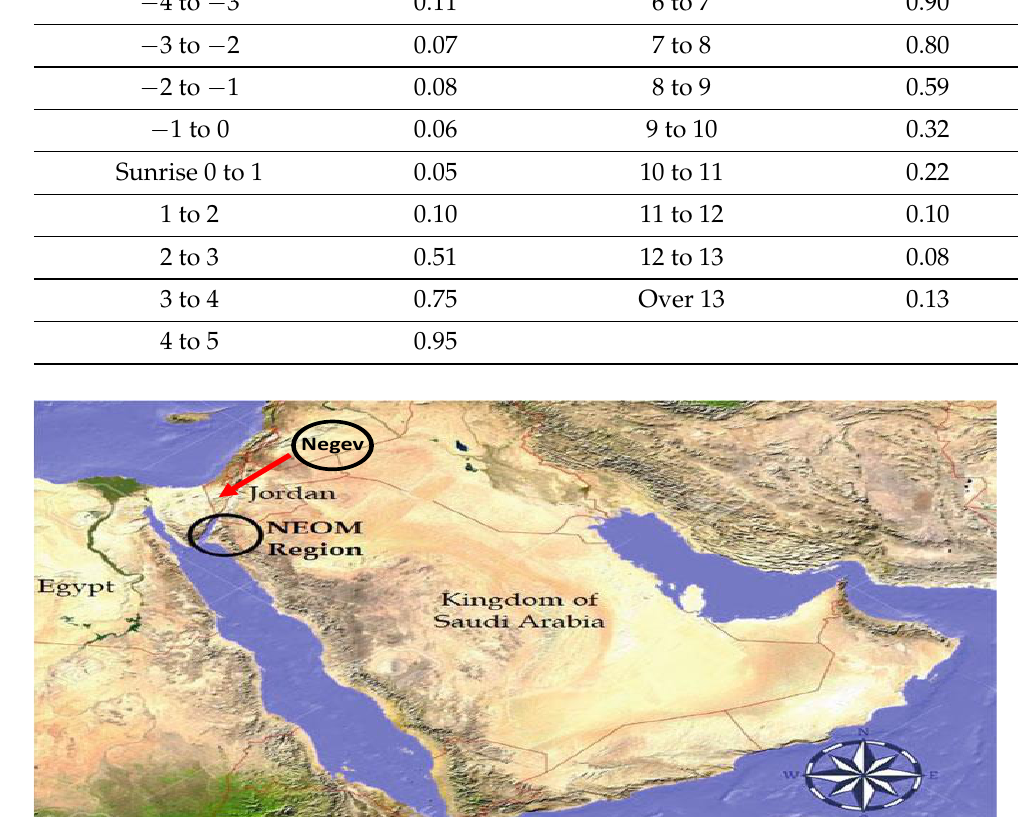
Figure 2. Map of Saudi Arabia with the NEOM City Location Marked